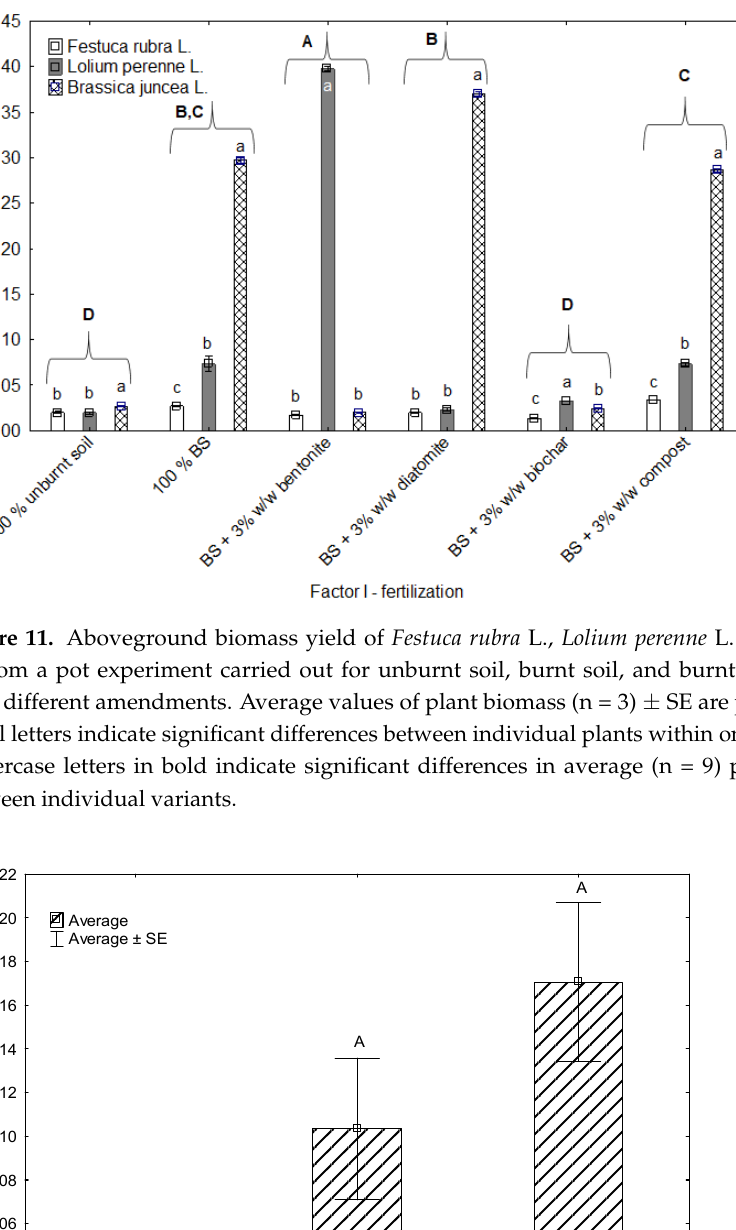
Figure 12. Aboveground biomass yield of Festuca rubra L., Lolium perenne L. and Brassica juncea L. from a pot experiment carried out for unburnt soil, burnt soil and burnt soil supplemented with different amendments. Average values (n = 18) ± SE are presented. Different letters indicate significant differences ( P < 0.05).